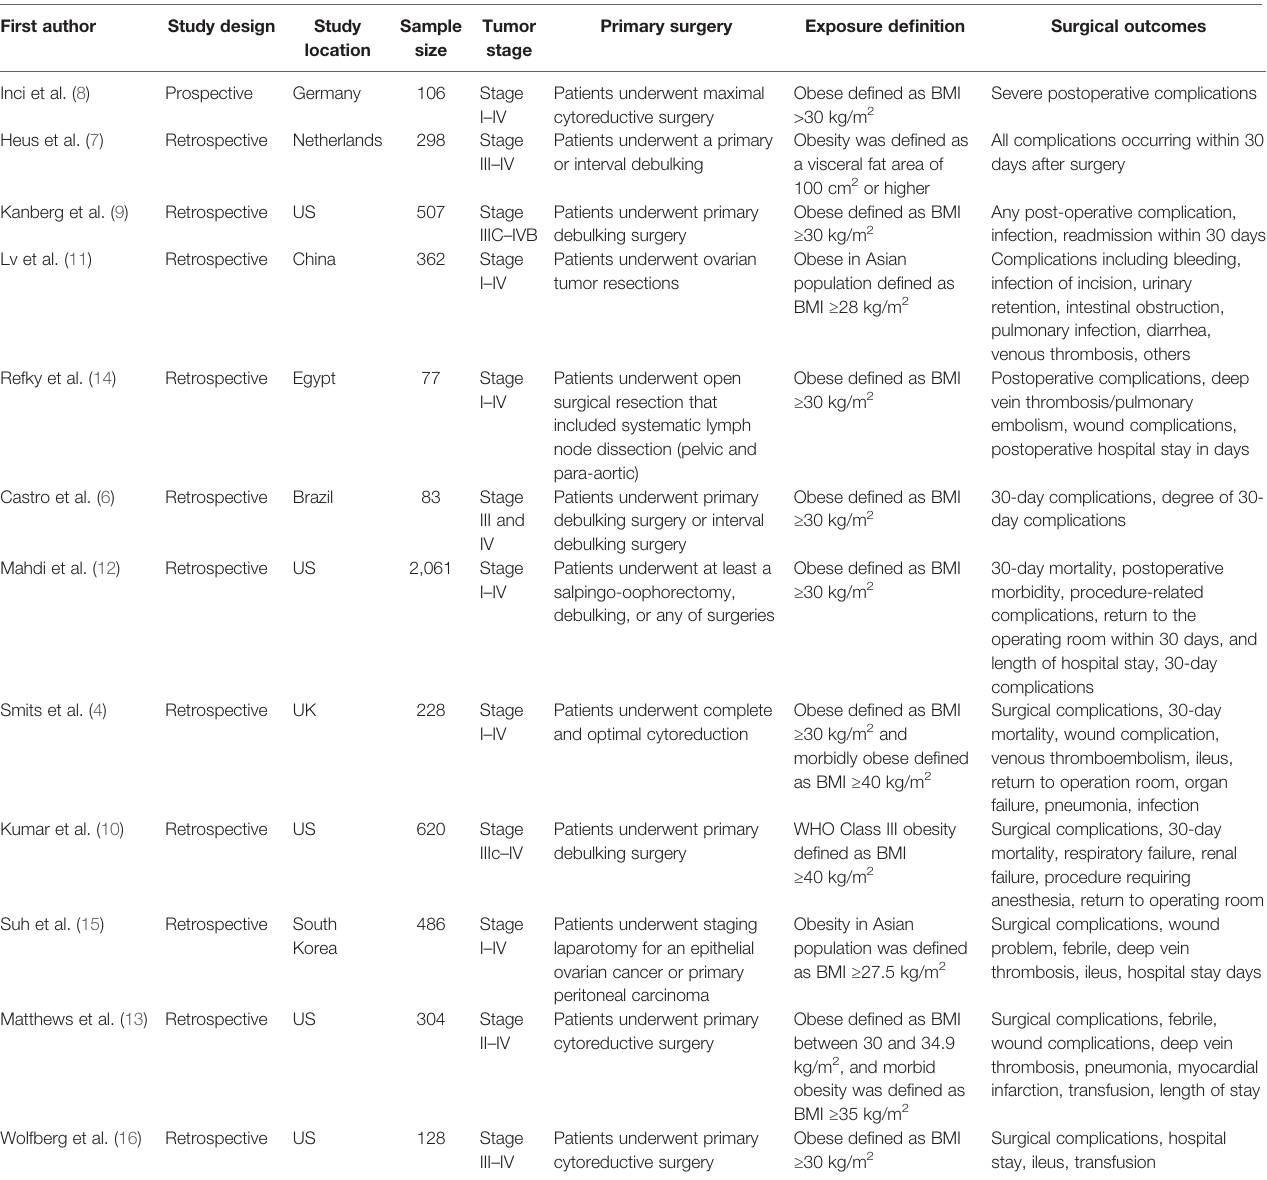
TABLE 1 | Characteristics of studies in the